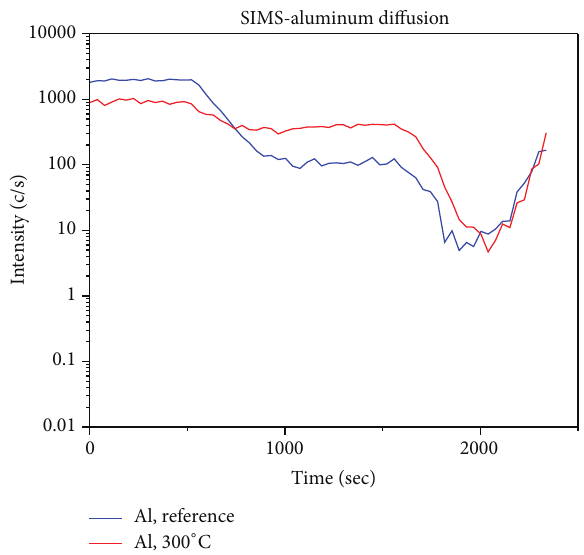
Figure 9: SIMS measurements showing Al diffusion from front contact to CIGSSe absorber layer. In blue the reference sample and in red the sample at 300 ∘ C for 600